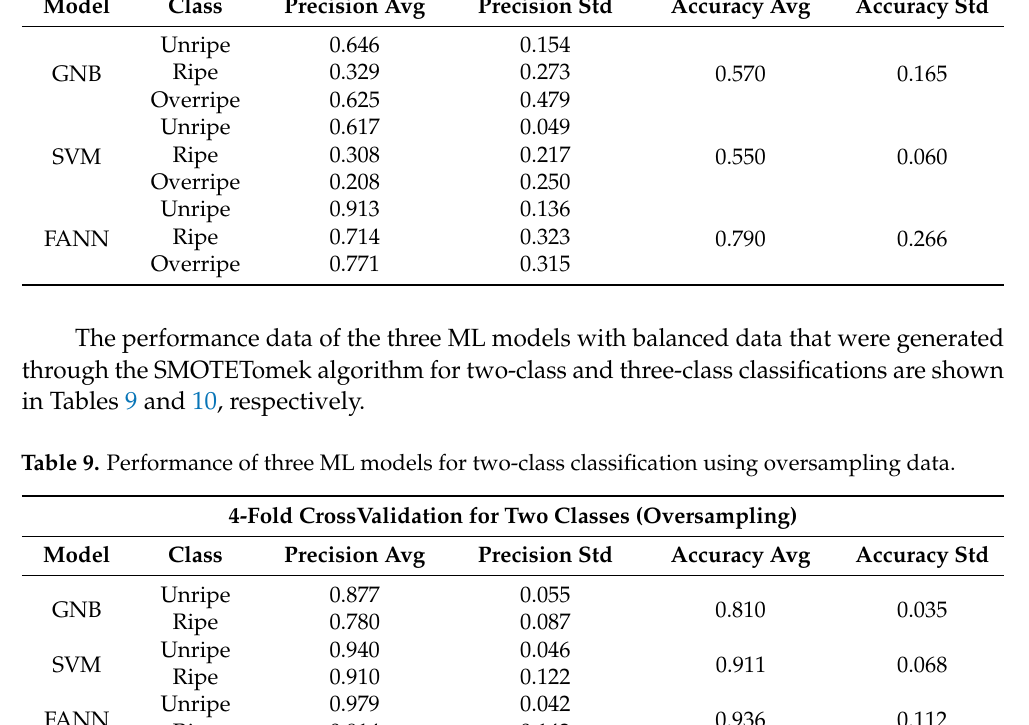
Table 8. Performance of three ML models for three-class classification using original data. 4-Fold CrossValidation for Three Classes